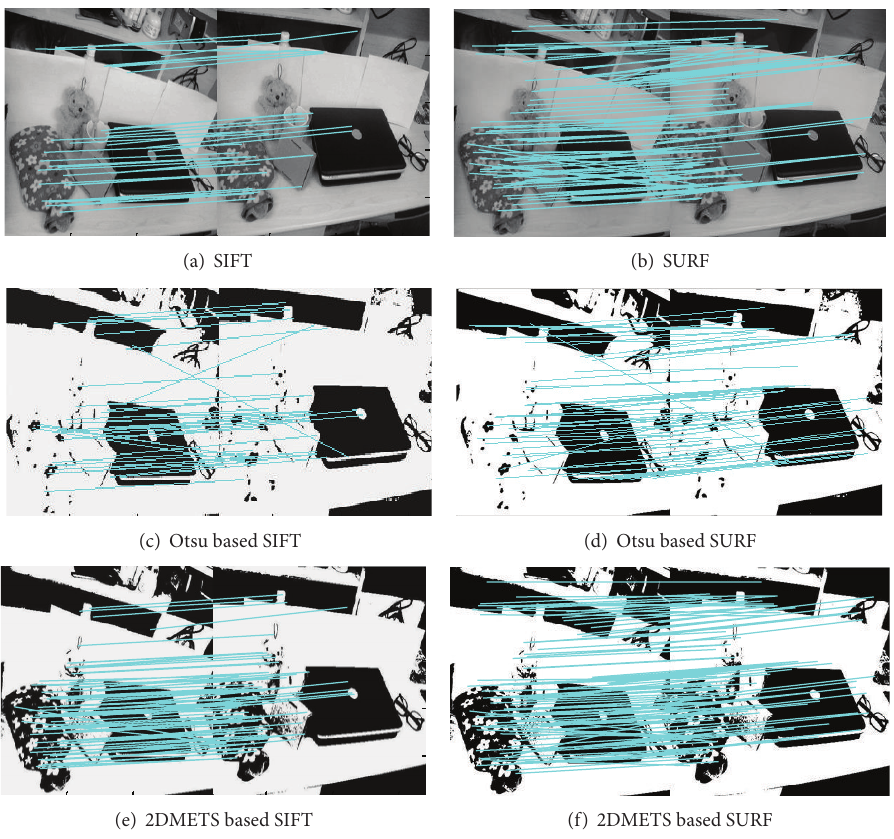
Figure 7: Target matching for images in group